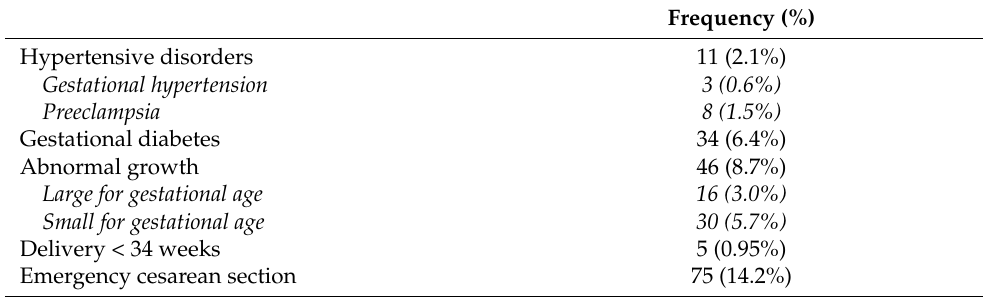
Table 2. Obstetric